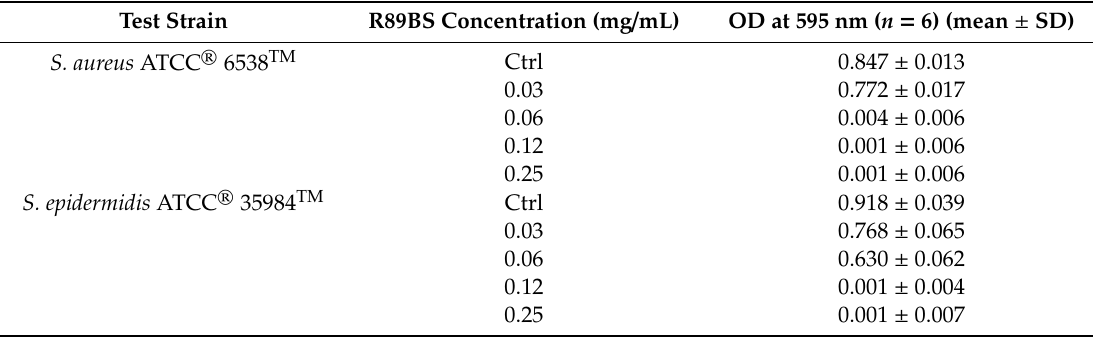
Table 1. Effect of R89 biosurfactant (R89BS) on Staphylococcus spp. planktonic cells. Results are represented as means and standard deviations (SD). Minimal inhibitory concentration (MIC) values are provided, as observed with the unaided eye. OD—optical density.